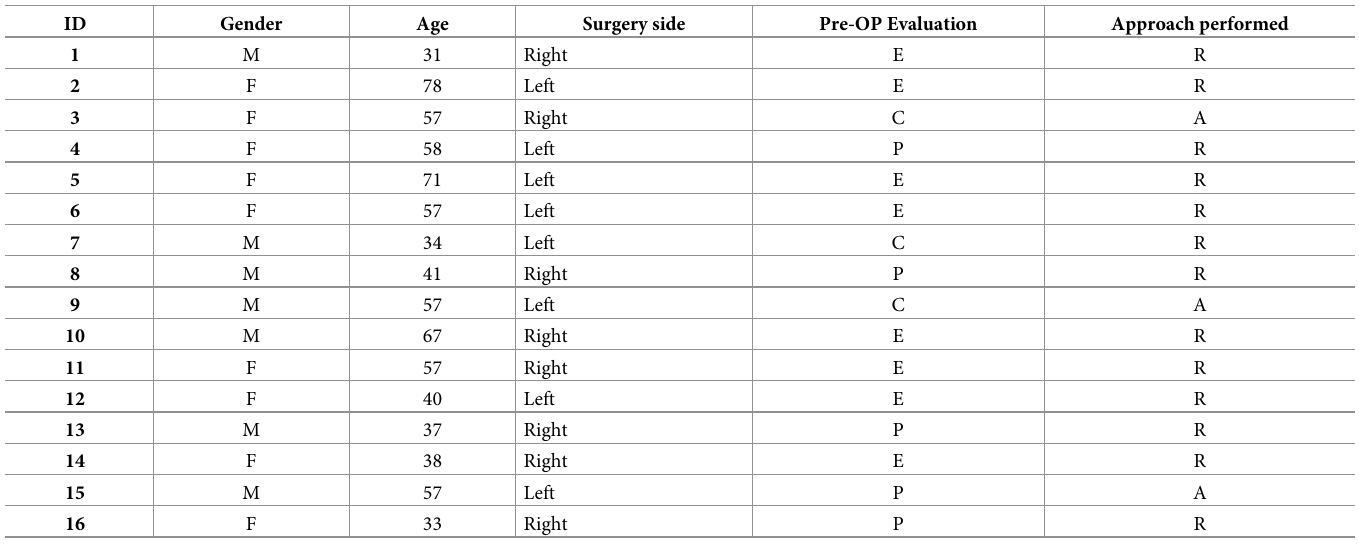
Table 1. Demographic data of patients participating in our study (column 1 to 4). Summary of the pre-surgical evaluation (column 5) and surgical approach per- formed to access the stapedius muscle (column 6).